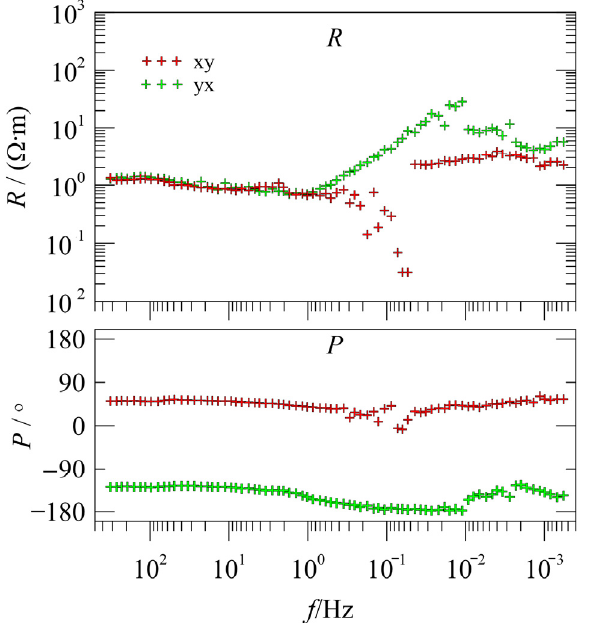
Figure 14. The apparent resistivity ( upper panel) and the phase of the test dataset ( lower panel) of the MT data. The red curve shows the apparent resistivity and phase curves in the xy direction. The green curve shows the apparent resistivity and phase curve in the yx direction.